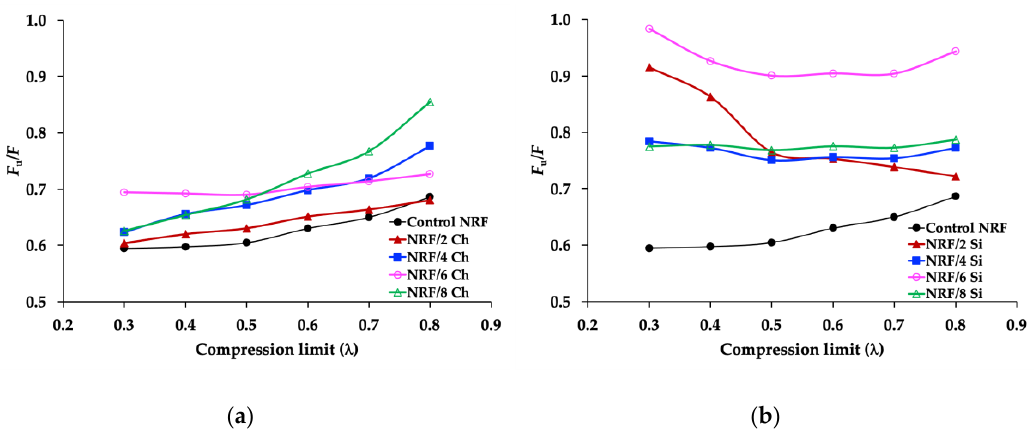
Figure 10. Relative internal energy contribution to the compression force ( F u / F ): ( a ) NRF with charcoal loading compared to control NRF; ( b ) NRF with silica loading compared to control NRF.